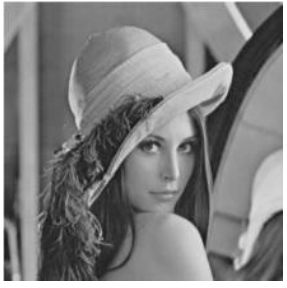
Figure 2. Grayscale image.